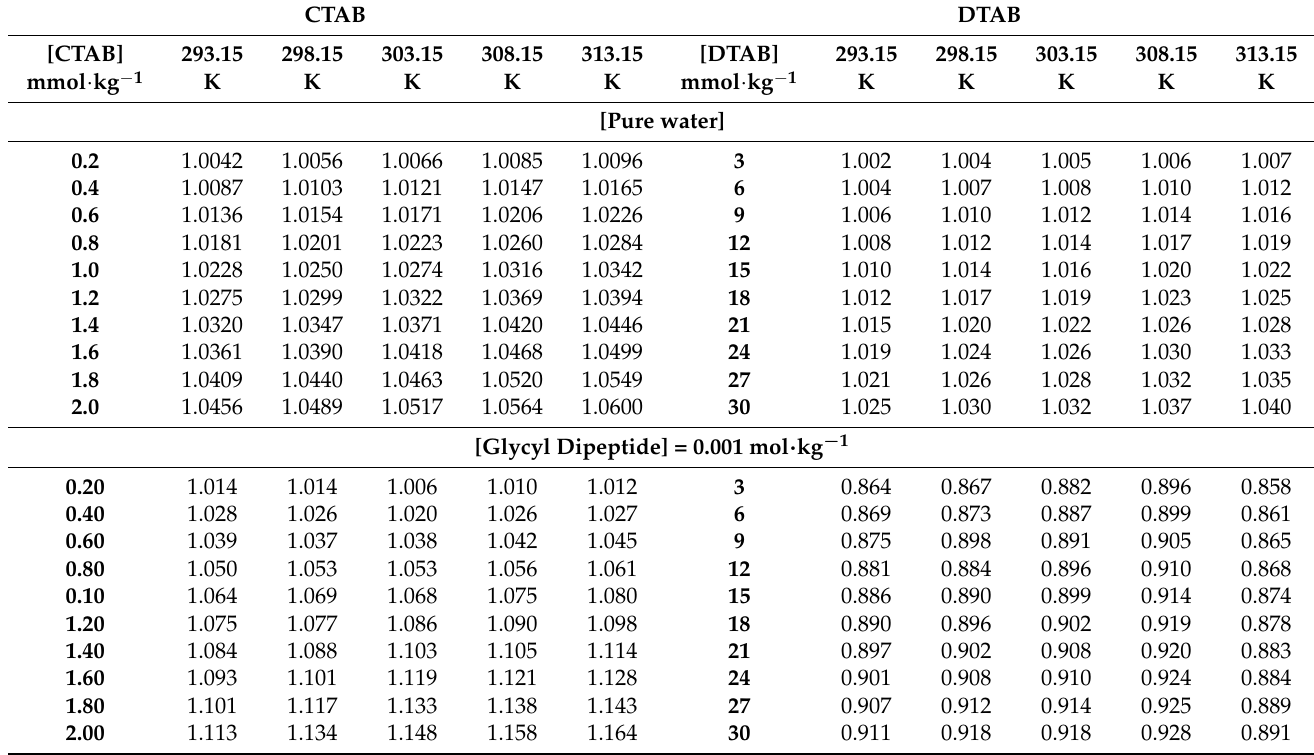
Table 5. Relative viscosity, η r values for CTAB and DTAB in pure water and 0.001, 0.005